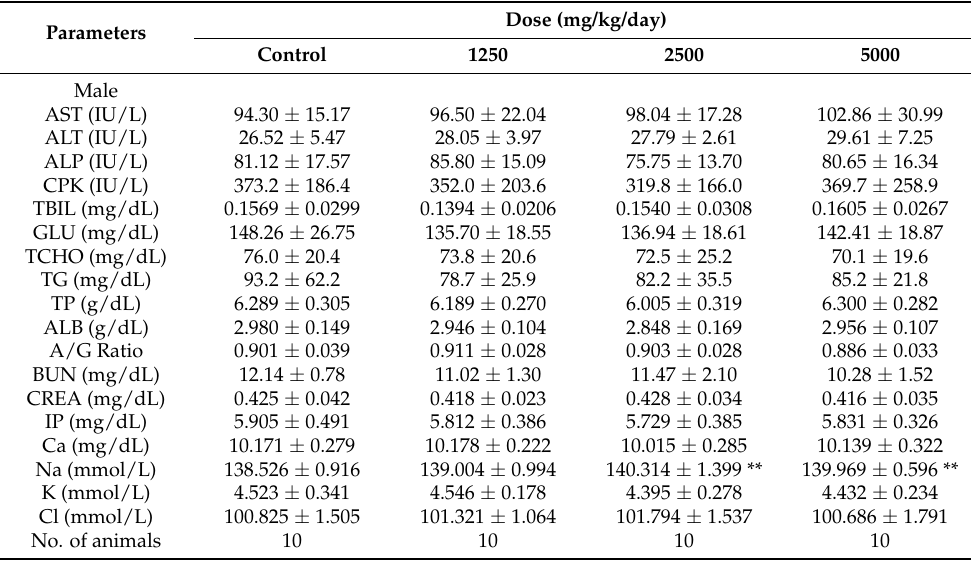
Table 9. Serum biochemical values in 13 weeks repeated oral dose toxicity of WG extract in male rats.